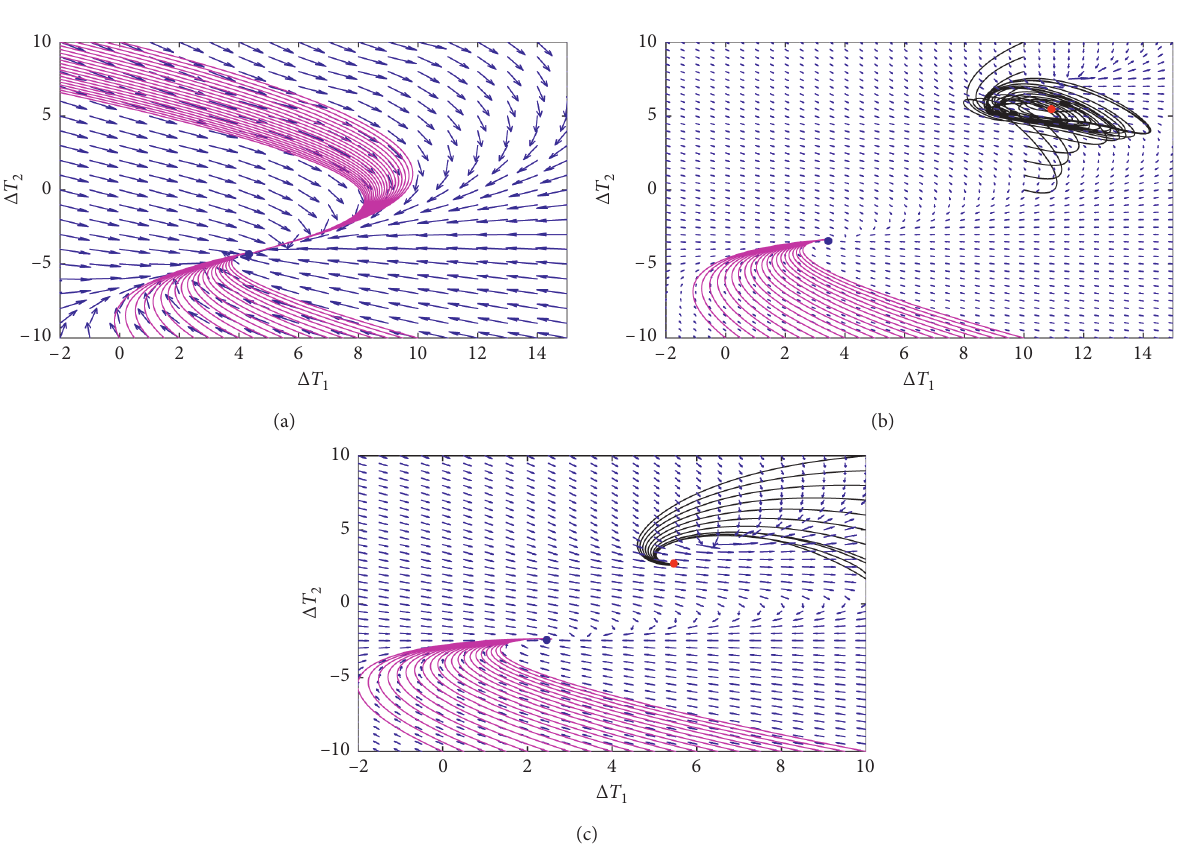
states converge to the same steady state.